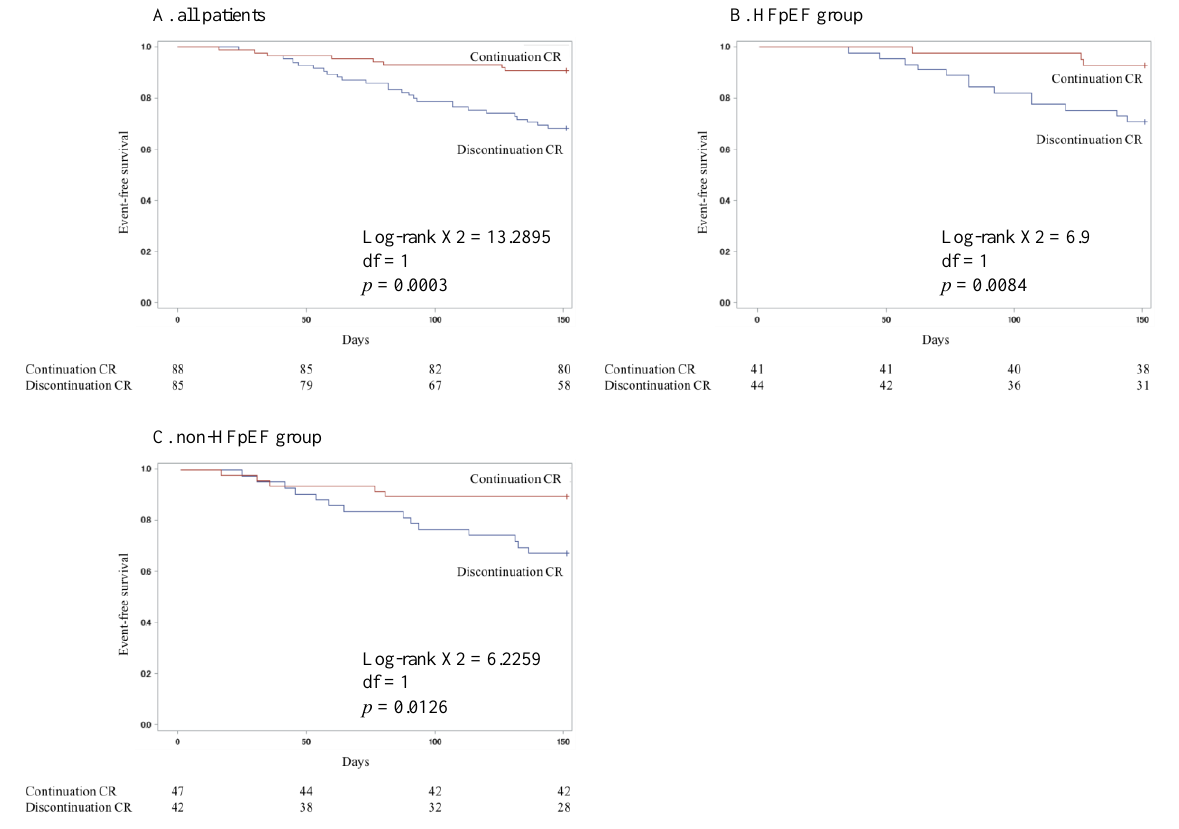
Figure 1. Kaplan–Meier curves for all-cause death and hospital admissions in the continuation and discontinuation groups in all HF patients ( A ) and in the HFpEF ( B ) and non-HFpEF ( C) groups.